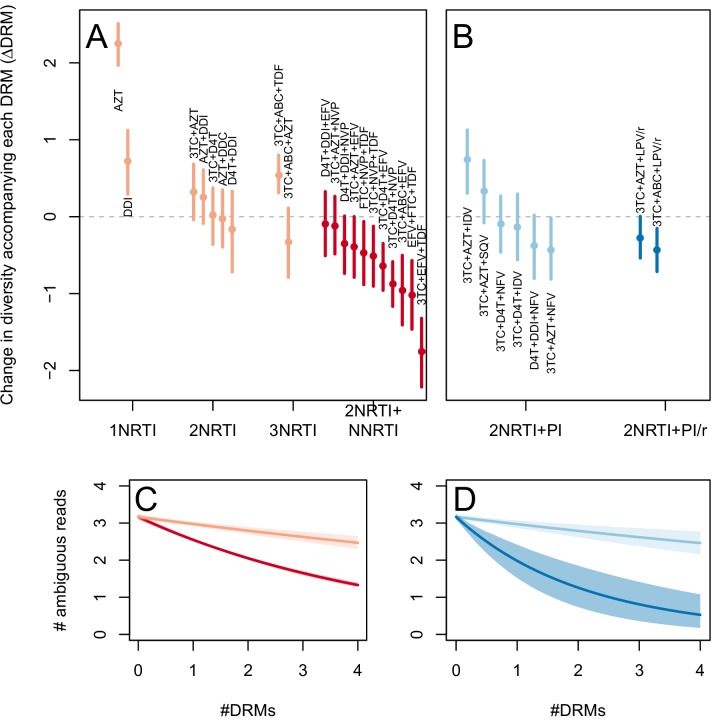
Drug resistance mutations are correlated with diversity reduction differently in different types of treatments when all years are included.This figure is analogous with Figure 3 from the main text, but in this case, the data include 45 sequences sampled before 1995. The inclusion of these sequences substantially changes the effect of the subsampling procedure, which explains the difference in scales of these figures (see Materials and methods: p-thinning to adjust for the effect of year). The figure caption is otherwise shared with Figure 3.